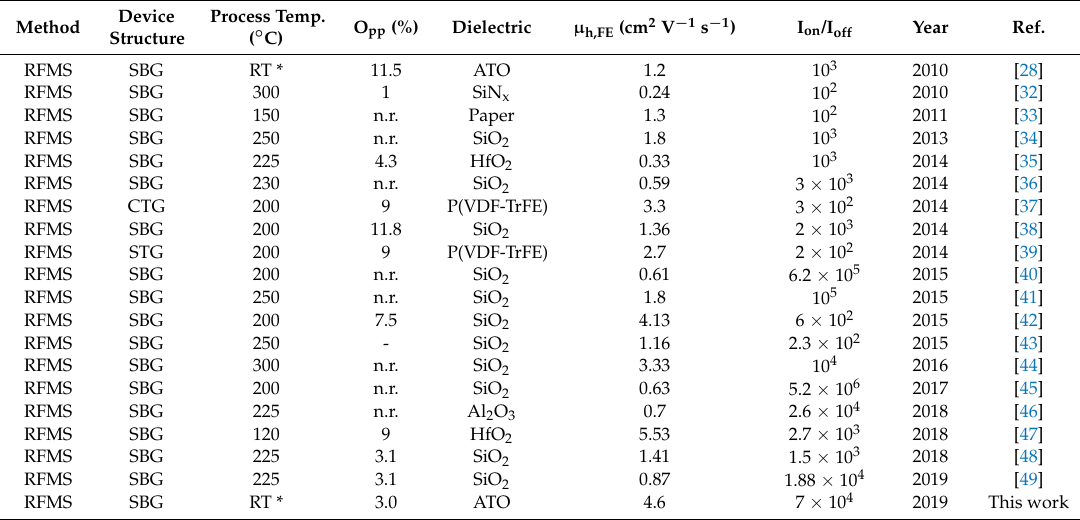
Table 1. Recent developments concerning the performances of p-type SnO TFTs processed by Radio Frequency Magnetron Sputtering (RFMS), using different type of device configurations, O pp , dielectrics and process